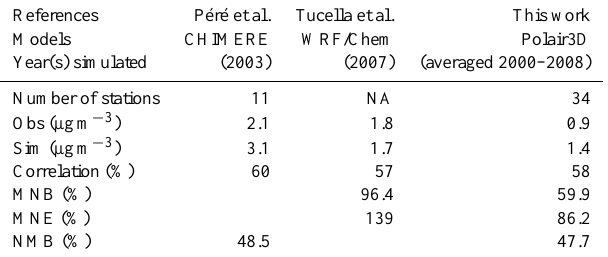
Table B4. Comparison for ammonium with P´er´e et al. (2010) and Tuccella et al. (2012). The data from this work are averaged over